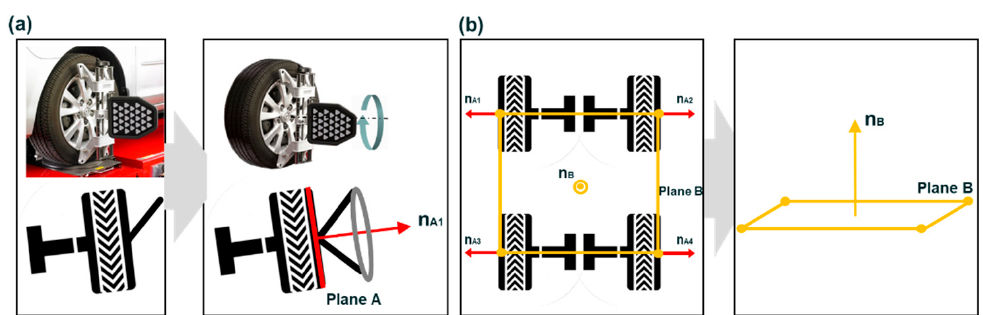
Figure 3. Creation of wheel planes and normal vectors. ( a ) Plane A. ( b ) Plane B.